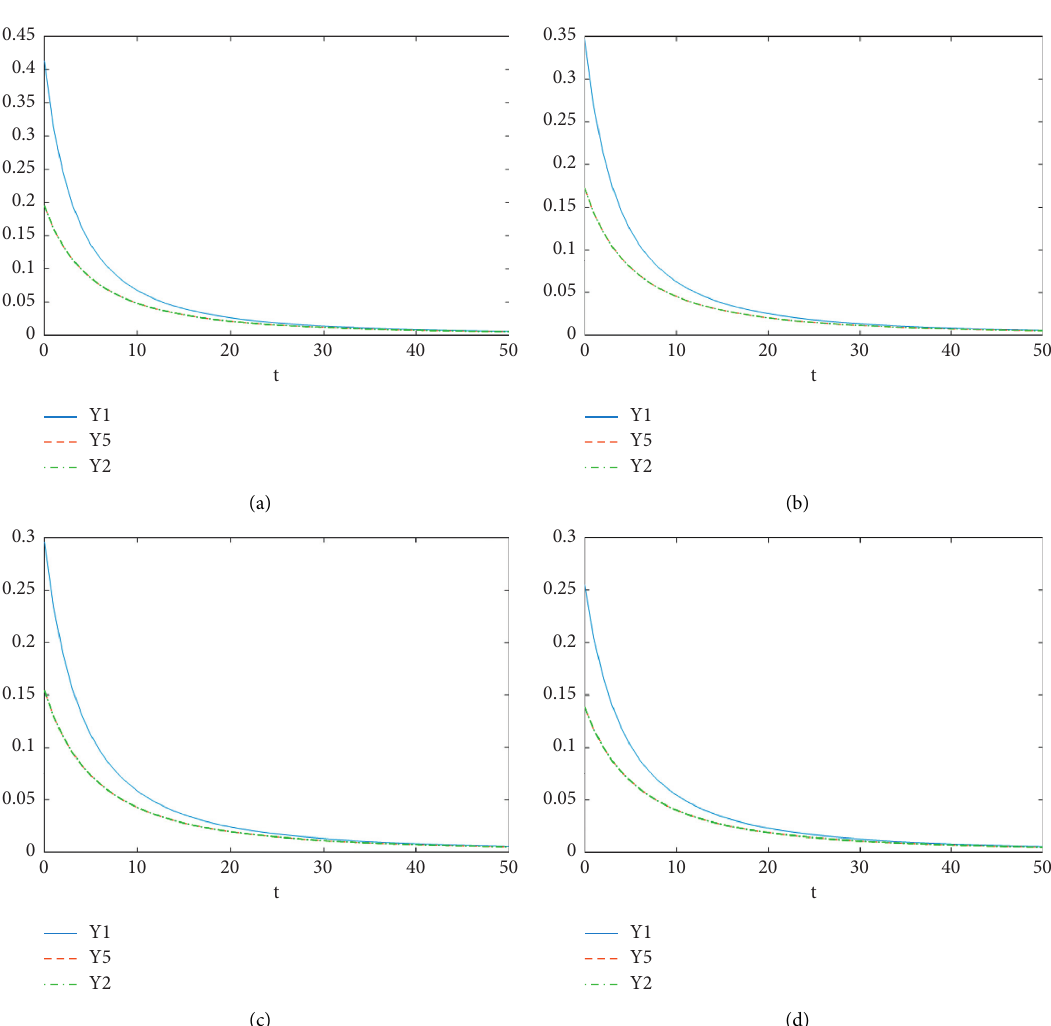
� 6 . 5, s � 5 . 8). (a) β � 0 . 2. (b) A B